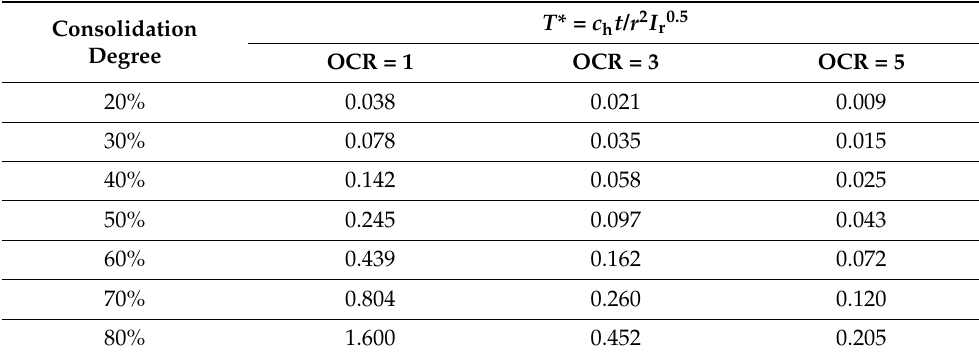
Figure 11. The consolidation degree normalized time curve under different OCR [20]. Table 2. Recommended T * values under different OCR at cone shoulder ( u 2 )